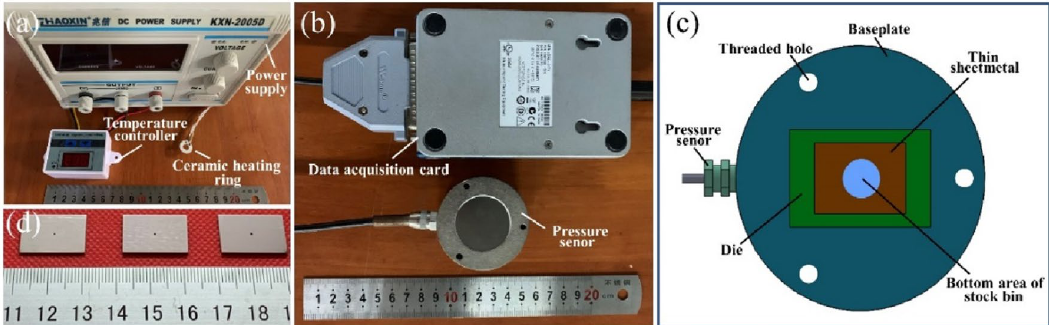
Figure 3. Physical diagram of the experimental equipment and the pressure sensor force measurement diagram. (a) physical view of heating module parts. (b) pressure acquisition module physical drawing. (c) schematic diagram of pressure sensor force measurement . (d) die physical picture.